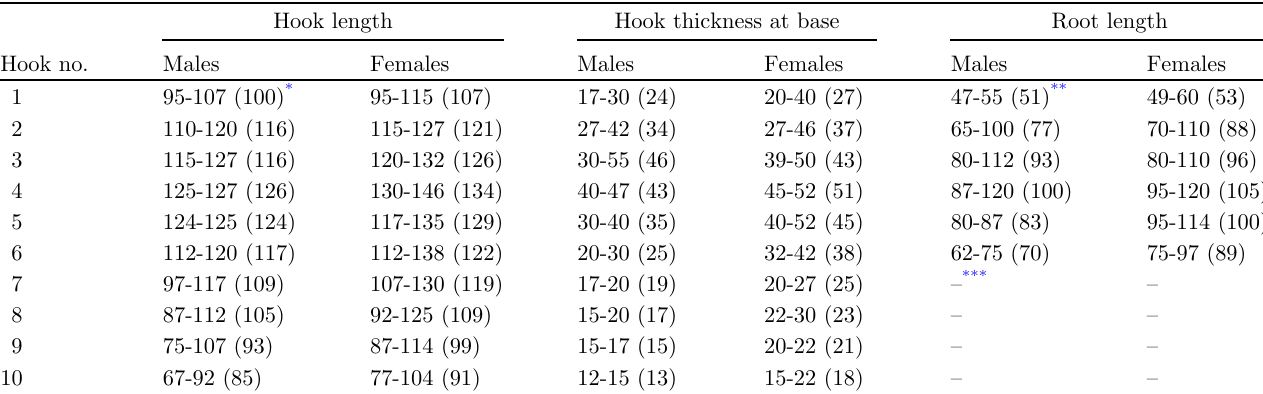
Table 2. Measurements of proboscis hooks and roots of Cavisoma magnum from Mugil cephalus in the Arabian Gulf. Hook